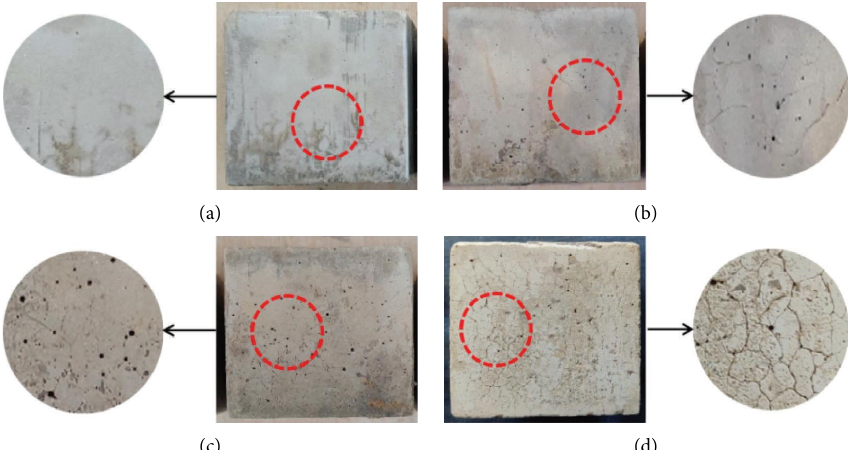
Figure 7: Te apparent characteristics of the glass fber-reinforced cemented soil in a water environment (a) after 0 cycles; (b) after 2 cycles; (c) after 4 cycles; (d) after 6 cycles.